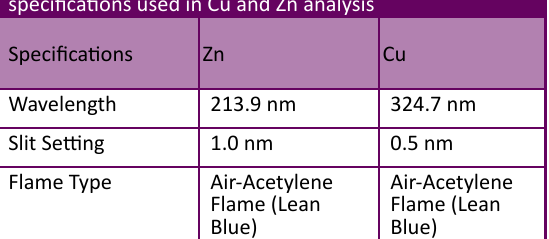
Table 1. Atomic Absorption Spectrophotometer specifications used in Cu and Zn analysis Specifications